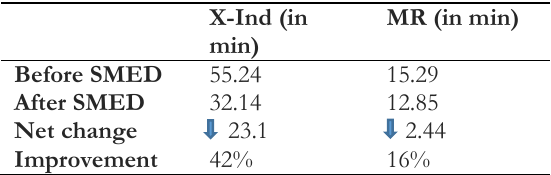
Table 3. Results before and after